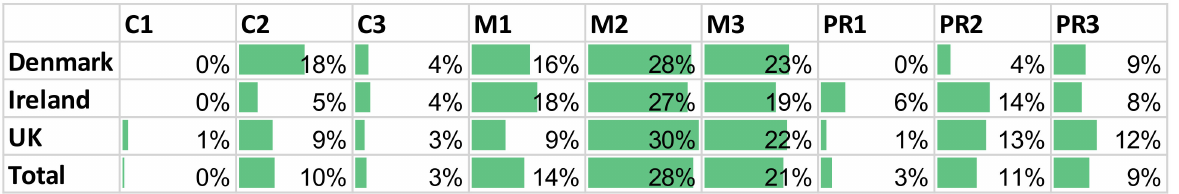
Figure 2. Distribution of scale and dimension targets among NREAP policies.